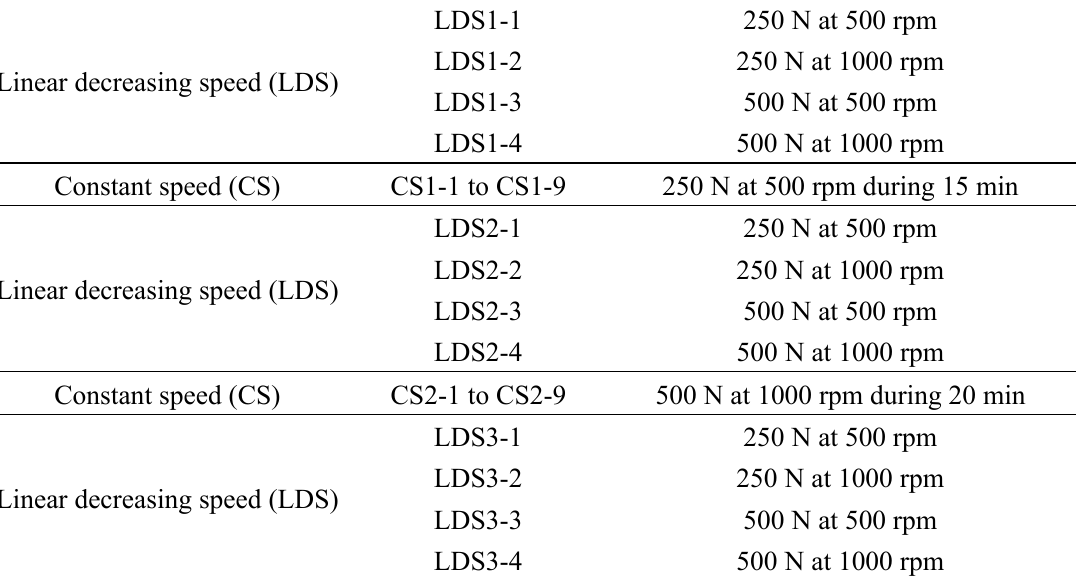
Table 2. Description of noise test procedure applied for each sample of the different brake pad